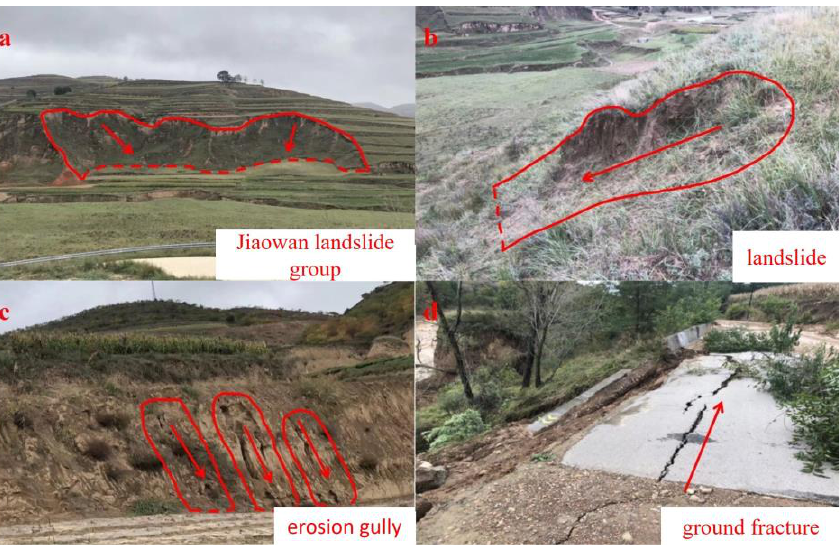
Figure 5. Field investigation. ( a ) Jiaowan landslide group; ( b ) landslide; ( c ) erosion gully; ( d ) ground